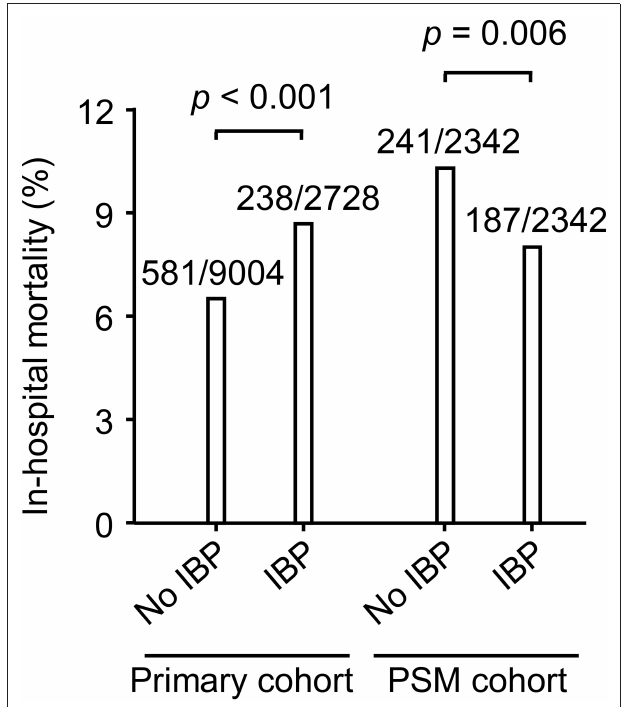
FIGURE 4 | Association between IBP measurement and in-hospital mortality in each cohort. PSM, propensity-score matched; IPTW, inverse probability of treatment weighting; CI, confidence interval.